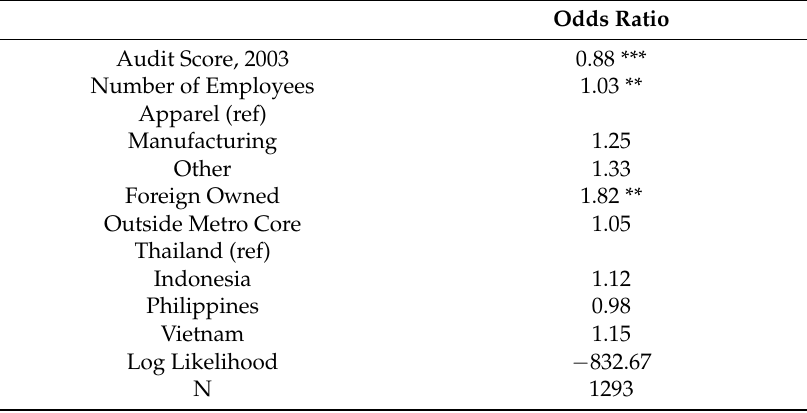
Table 3. Logistic Regression Results of the Likelihood that a Factory Will Be